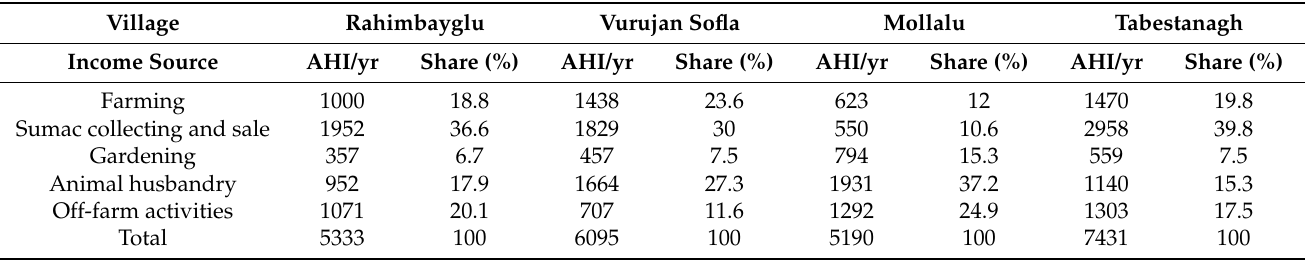
Figure 2. Sumac trees and fruit harvesting by local people in Arasbaran forests. Table 2. Mean of annual household incomes (USD) (AHI/yr) and share of different income sources in sumac collected